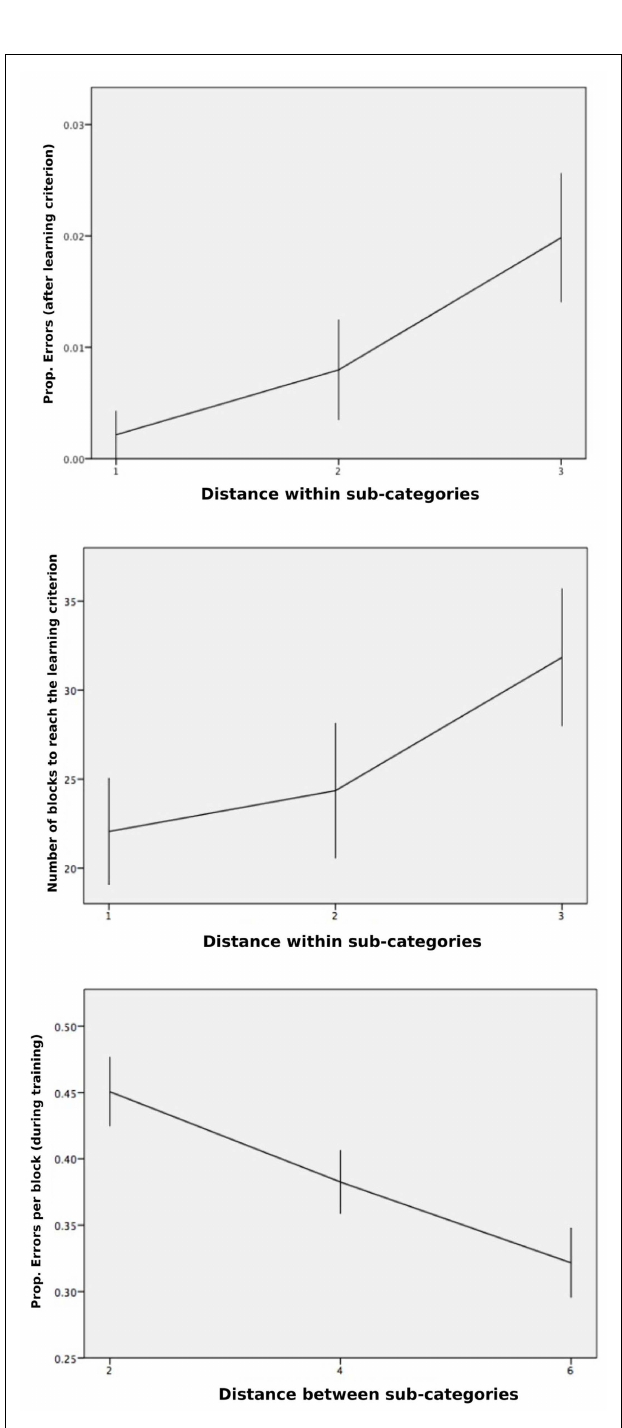
FIGURE 4 | Classification performance. Top, shows an increase in the mean proportion of errors per block, computed for the blocks that passed the learning criterion, given the distance on the irrelevant dimension (i.e., greater dissimilarity within clusters). Middle, shows an increase in the mean number of blocks to learning criterion, given the distance on the irrelevant dimension. Bottom, shows a decrease in mean RTs (transformed by a log function) after the learning criterion was reached, as the distance increased on the relevant dimensions (i.e., greater dissimilarity between cluster). Error bars are ± 1